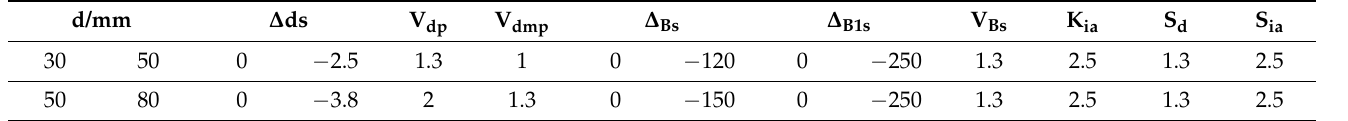
Table 4. SKF group P2-grade bearing